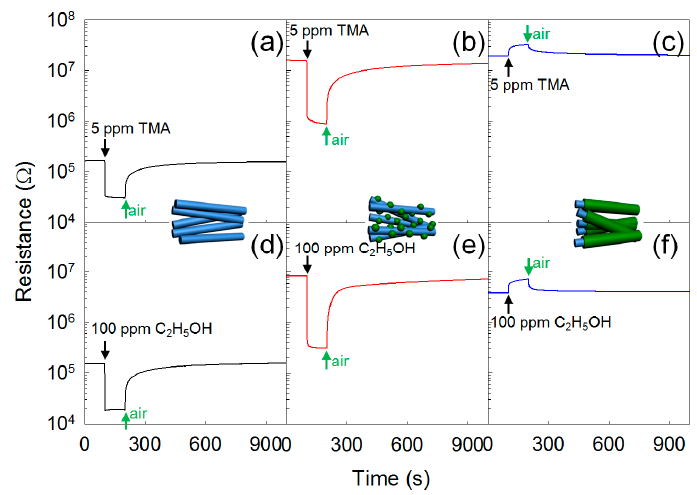
Figure 3. Dynamic sensing transients of ( a ) ZnO NWs; ( b ) Cr 2 O 3 -decorated ZnO NWs; and ( c ) ZnO-Cr 2 O 3 core-shell nanocalbes (NCs) to 5 ppm trimethylamine (TMA) at 400 ◦ C. Dynamic sensing transients of ( d ) ZnO NWs; ( e ) Mn 3 O 4 -decorated ZnO NWs; and ( f ) ZnO-ZnMn 2 O 4 core–shell NCs to 100 ppm C 2 H 5 OH at 400 ◦ C. Adapted from [80,84] with permission; ( a – c ) [80] Copyright (2012) IOP Publishing Ltd.; ( d – f ) [84] Copyright (2012) American Chemical Society.